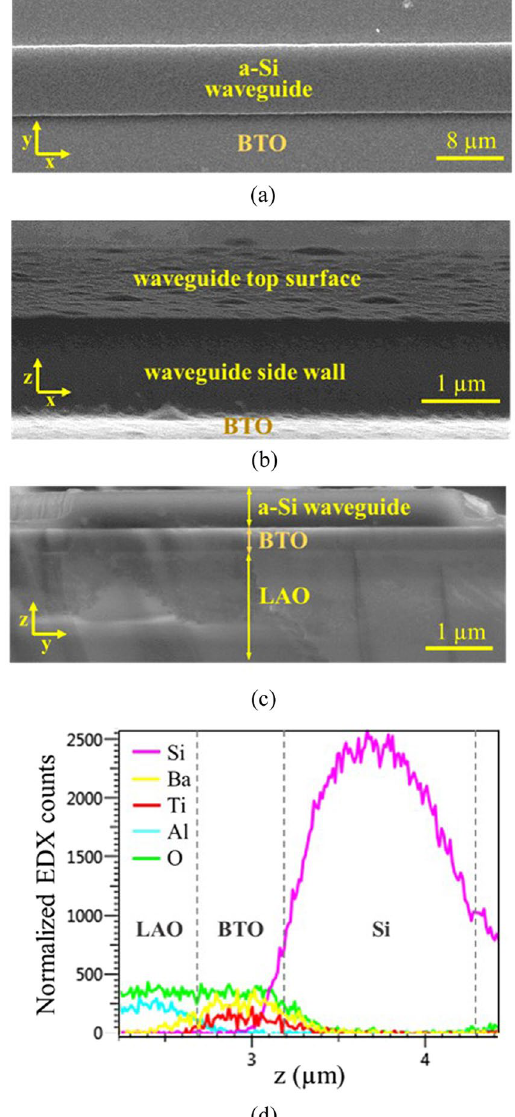
Figure 1. SEM images of a 10 μ m wide Si-on-BTO waveguide captured from ( a ) the top, ( b ) the side, and ( c ) the cross-section of the device. A clear waveguide surface, smooth Si-BTO interface, and sharp waveguide edges were observed. ( d ) EDX element line scanning determined the structure and the composition of each device